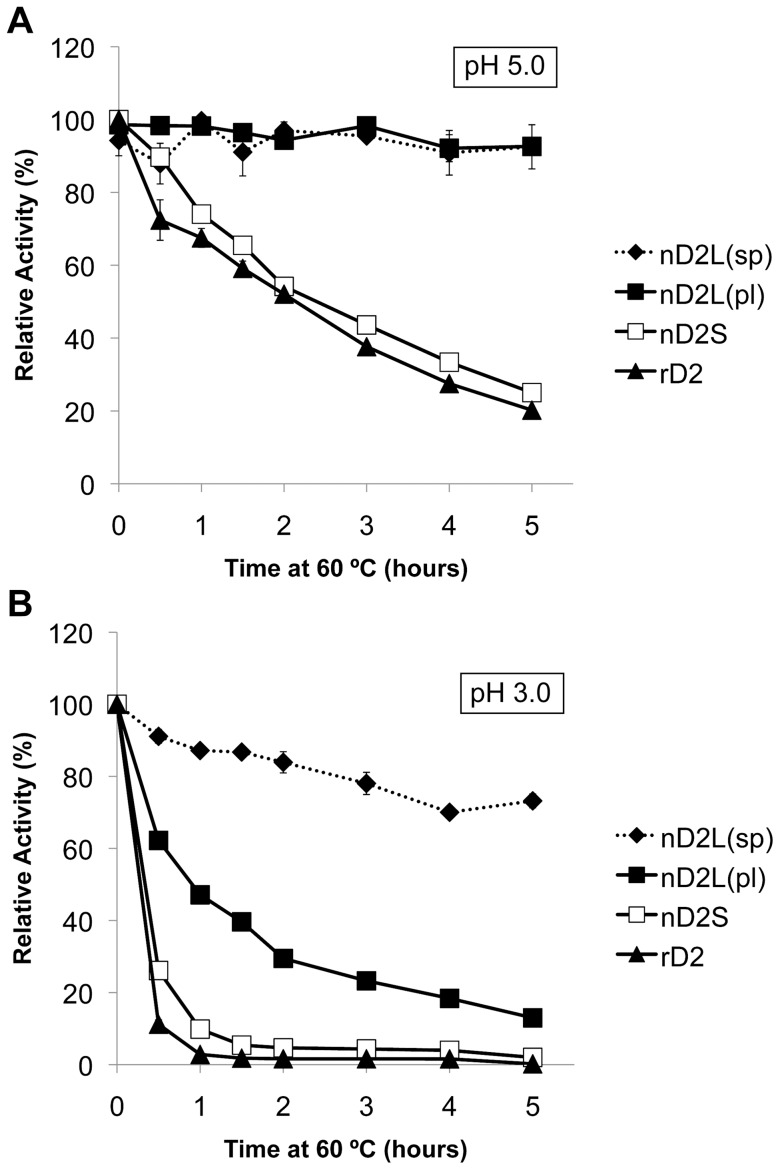
nD2L is more thermostable than smaller forms at pH 5.0, and nD2L purified from spore-inoculated culture (even more extensively glycosylated) is thermostable at pH 3.0.pNPG activity of D2 variants that were incubated at 60°C at pH 5.0 or pH 3.0 for indicated length of time. pl designates samples purified from plate-inoculated medium; sp designates samples purified from spore-inoculated medium.